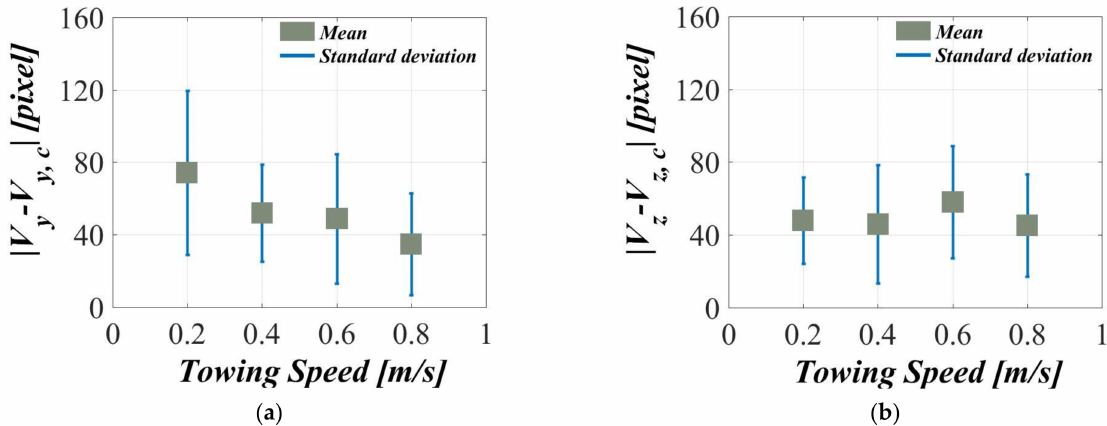
Figure 21. Statistical results of the dynamic guidance experiments in different towing speeds: the mean values and standard (cid:12) (cid:12) deviations of ( a ) (cid:12) V y − V y , c (cid:12) and ( b ) | V z − V z , c |